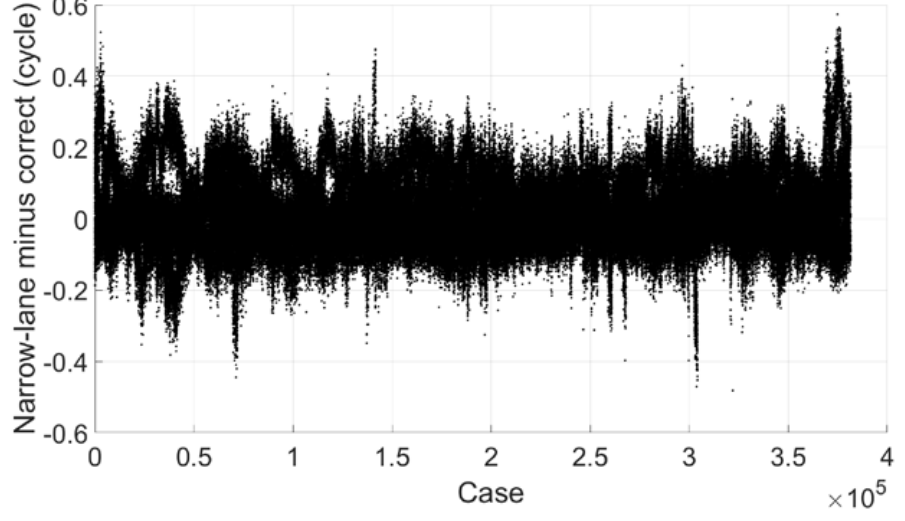
Figure 8. Narrow-lane ambiguity minus correct integer ambiguity (BDS).